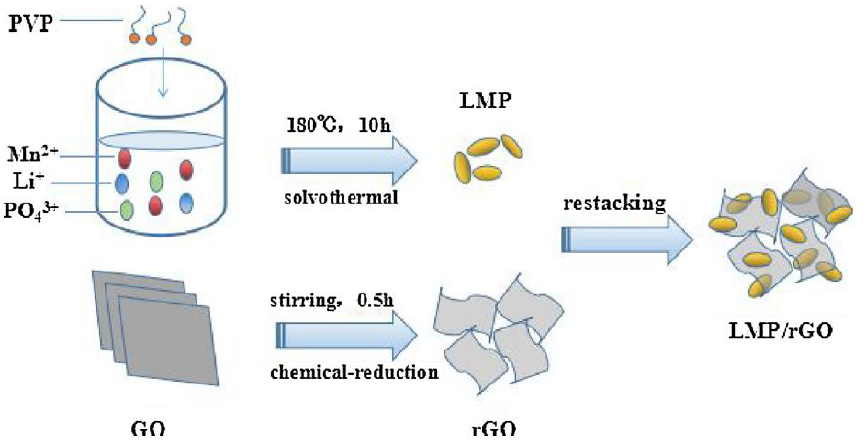
Figure 8. A schematic depiction of the LiMnPO 4 /rGO aerogel preparation method. Reproduced with permission from [80]. Copyright 2018, Elsevier.